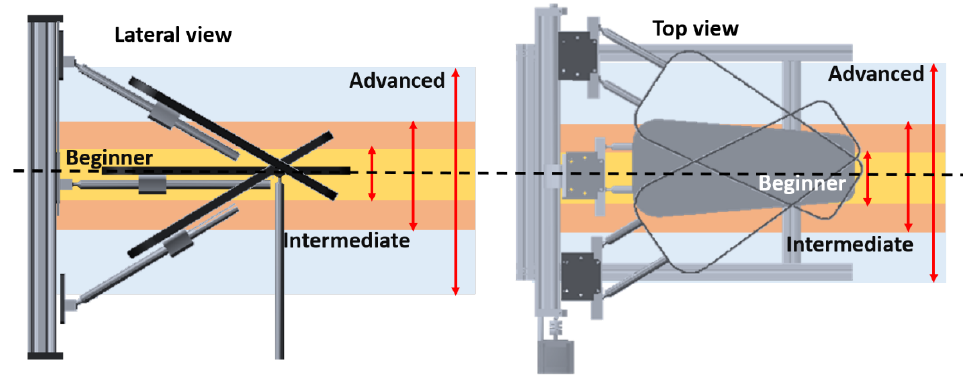
Figure 15. Rehabilitation levels on ankle rehabilitation machine.